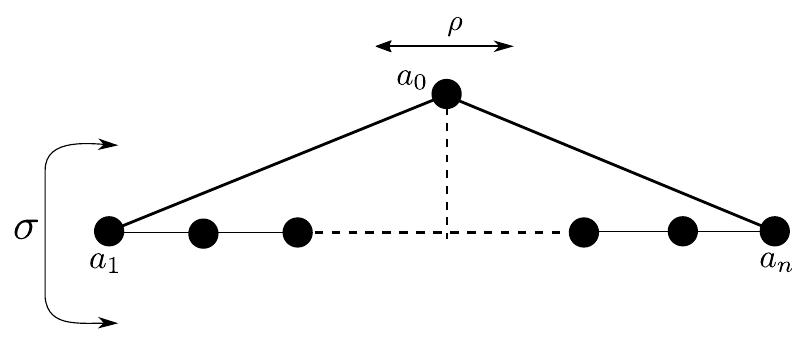
Figure 10 . Extended Dynkin